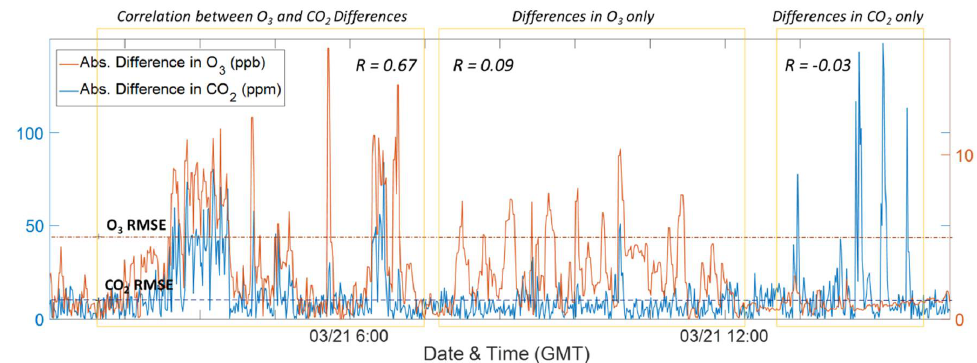
Figure 7. Time series of absolute differences between Y-Pod B1 and Y-Pod B5 for CO 2 (blue) and O 3 (red), the RMSE for both the CO 2 and O 3 sensors are indicated using dotted lines. The yellow boxes highlight periods where the differences in the two signals are well-correlated verses periods where the differences are occurring primarily in the CO 2 or O 3 signal. The correlation coefficient (R) has been added to contrast the different periods.